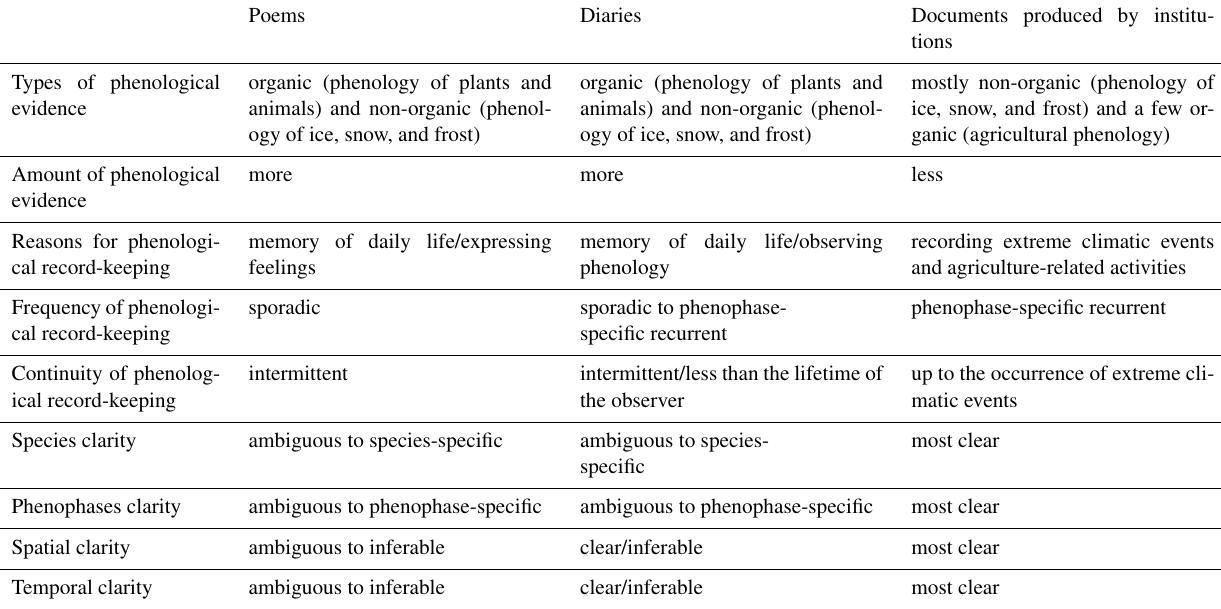
Table 2. Comparisons among the phenological evidence from poems, diaries, and documents produced by institutions in